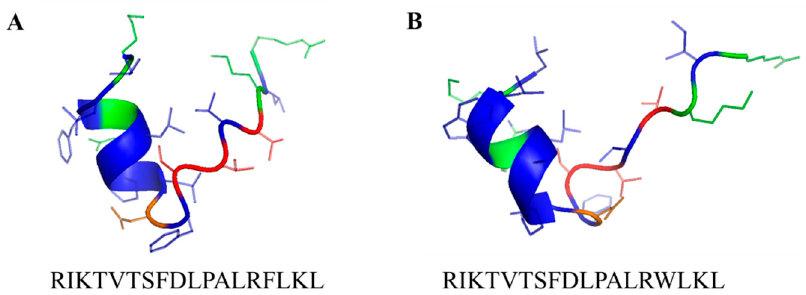
Figure 1. Peptide sequence and secondary structure of ( A ) Leg1 and ( B ) Leg2 [5] predicted with I-Tasser (https://zhanglab.ccmb.med.umich.edu/I-TASSER/, accessed on 22 May 2019) and gener- ated by PyMOL (http://www.pymol.org/, accessed on 13 January 2021). Hydrophobic amino acids are colored in blue, polar amino acids in red, positively charged amino acids in green and negatively charged amino acids in orange.